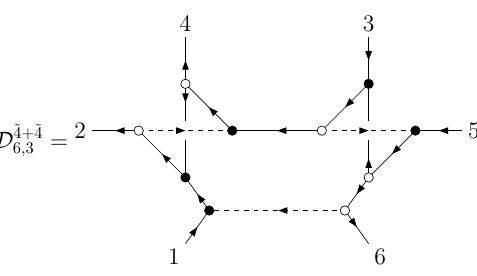
Figure 13 . On-shell diagram combining two 4-point amplitudes with split helicities. This diagram does not require any permutation sums since it is invariant under 2 ↔ 4 and 3 ↔ 5